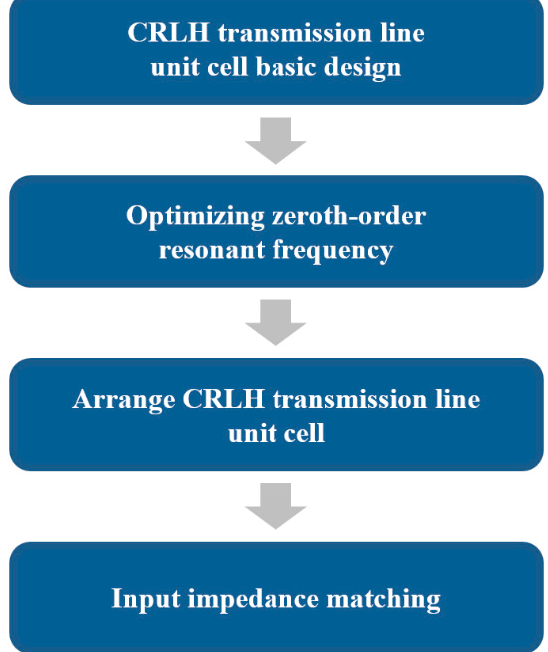
Figure 8. Design procedure for CRLH transmission line antenna.